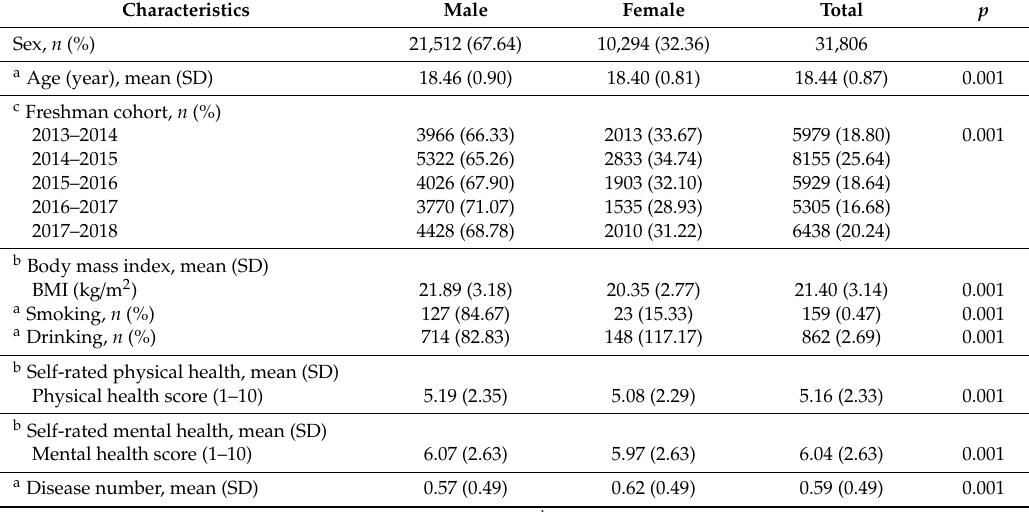
Table 1. The characteristics of survey